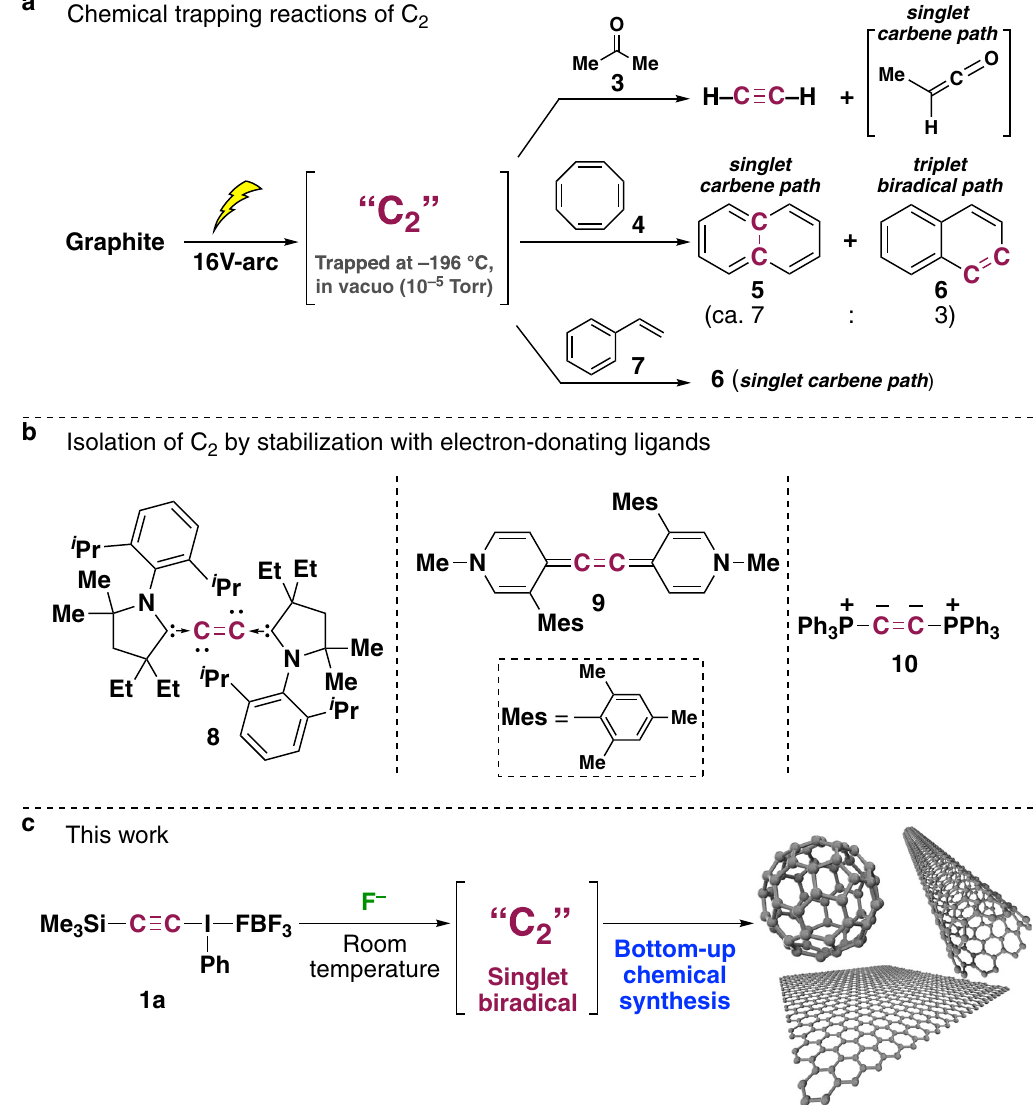
Fig. 1 Previous experimental work on C 2 and our synthesis of C 2 at low temperature in a fl ask. a Chemical trapping of C 2 generated by a carbon arc. b Isolation of C 2 stabilized by potent electron-donating ligands. c Our chemical synthesis of C 2 at ambient temperature under normal pressure by utilizing hypervalent alkynyl- λ 3 -iodane 1a